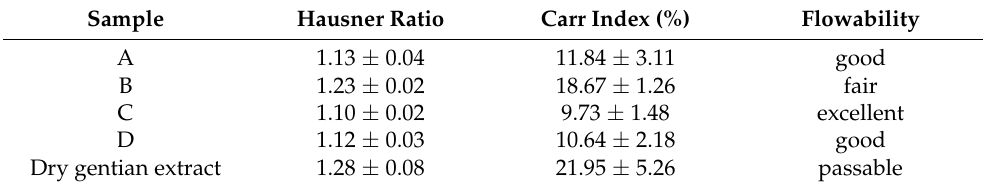
Table 5. Flowability of obtained solid lipid microparticles (A–D) and dry gentian extract.